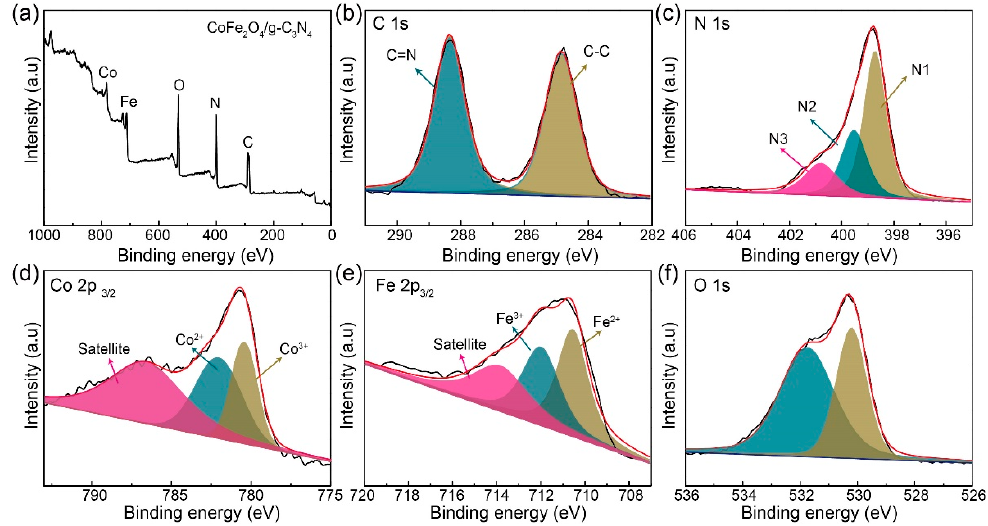
Figure 2. XPS survey spectra of CoFe 2 O 4 /g-C 3 N 4 : ( a ) full-spectrum scan, ( b ) C 1s, ( c ) N 1s, ( d ) Co 2p 3/2 , ( e ) Fe 2p 3/2 , and ( f ) O 1s.